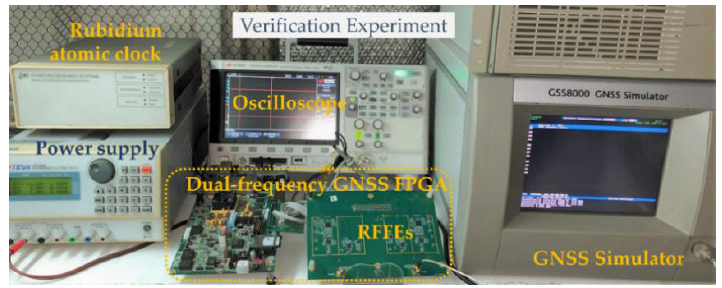
Figure 11. Verification environment.